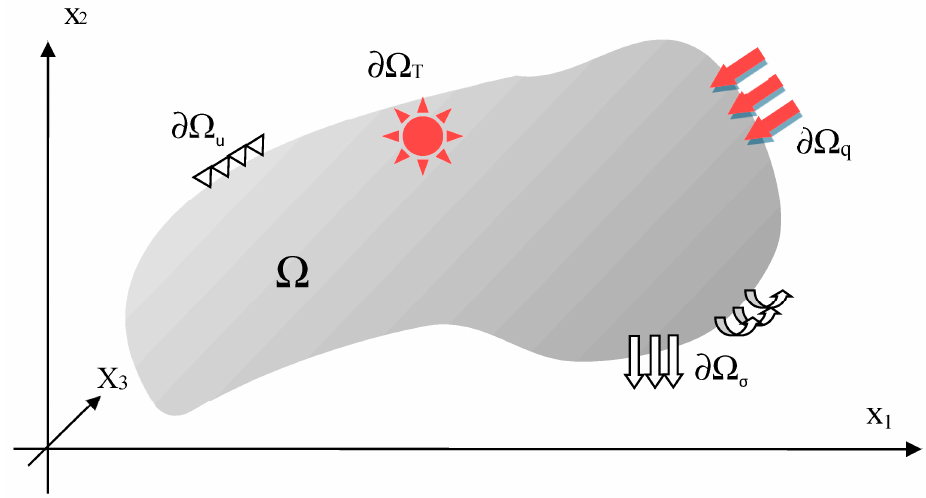
Figure 1. Boundary-initial thermo-mechanical problem of the homogeneous domain Ω .